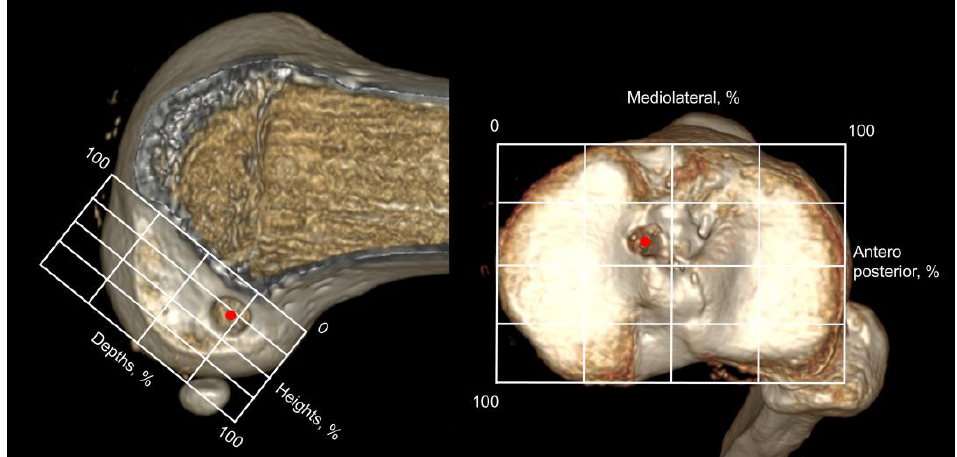
Figure 5. The center of the femoral and tibial tunnel (red dots) was calculated on 3-dimensional CT with the quadrant method. The height and depths of femoral tunnel position and anteroposterior and mediolateral tibial tunnel position were measured.